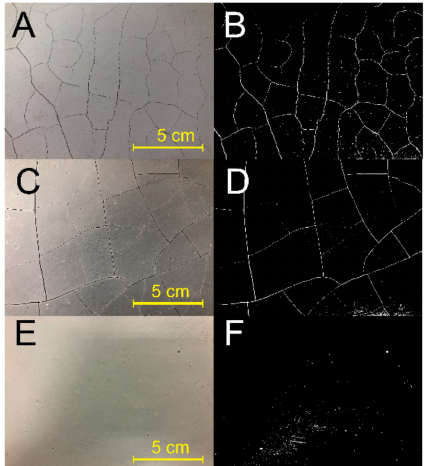
Figure 8. Coating appearance after being curing at ambient environment for 28 d. ( A ) \ ( B ) sample 1#, ( C ) \ ( D ) sample 2#, ( E ) \ ( F ) sample